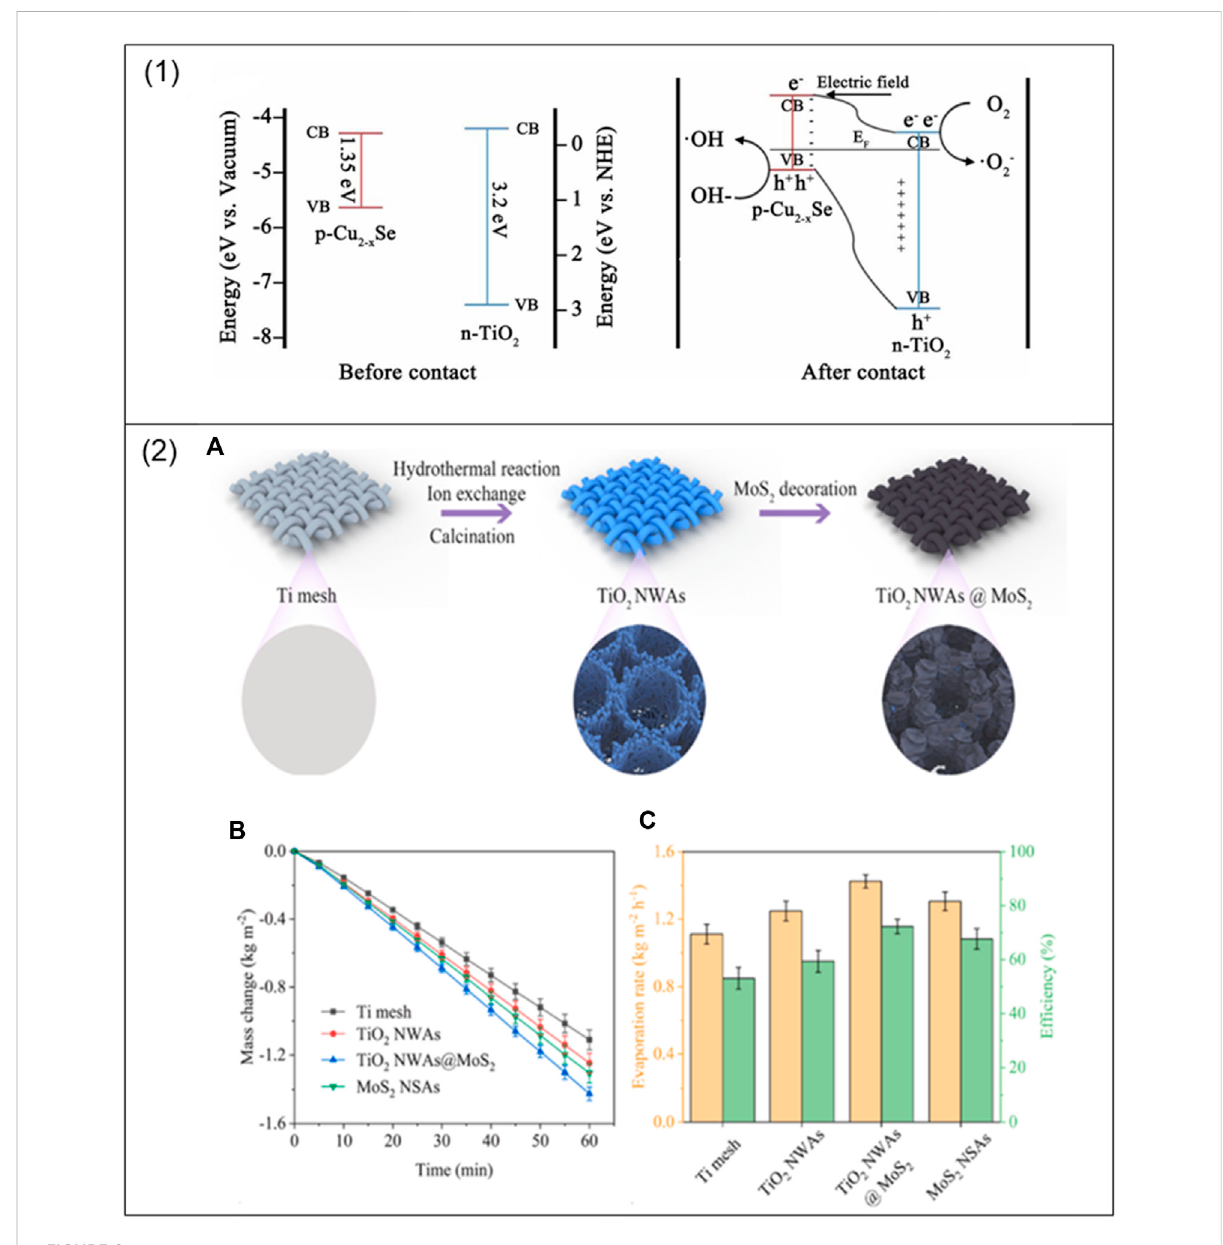
FIGURE 9 (1) Energy band structure diagrams of Cu 2-x Se and TiO 2 before and after contact. (CB: conduction band, VB: valence band, NHE: normal hydrogen electrode) (Renet al. 2019); Reproduced with permission. Copyright 2019 IWA publishing. (2) (A) Descriptive illustration of the